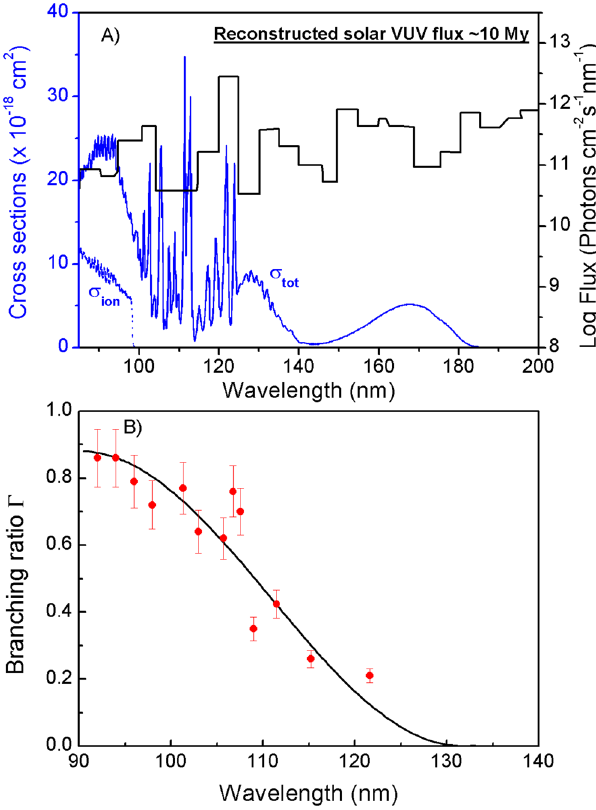
Fig. 4 The wavelength dependences of O atom quantum yields. Plot showing ( A ) the wavelength dependences of the reconstructed VUV solar fl ux (90 – 200 nm, the black lines) at ~10 My (10 My = 1 × 10 7 years, reconstructed from ref. 31 . The VUV solar fl ux at modern period or the interstellar radiation fi eld (ISRF) 41 also can be used, which may modify the yield of O-production a little, but the fi nal conclusion holds), the total absorption ( σ tot , the solid blue curve) 32 and photoionization ( σ ion , the dotted blue curve) cross-sections 42 of H 2 O, and ( B ) the quantum yield for forming O-atom photoproducts (O( 3 P/ 1 D) + 2H), Γ , determined in the present work (the red dot). It is noted that the predissociation rate of H 2 O is suf fi ciently fast that the fl uorescence quantum yield must be negligible, so the total photodissociation cross-section will be almost the same as the photoabsorption cross-section. The polynomial function through the latter data is used to derive the reported overall O product quantum yield (the black curve in B ). The quantum yields at λ = 111.5, 115.2, 121.57 nm are obtained from refs. 15,24,26 . The error bars represent the standard deviation (1 σ ) of three times measurements. Source data are provided as a Source Data fi le.